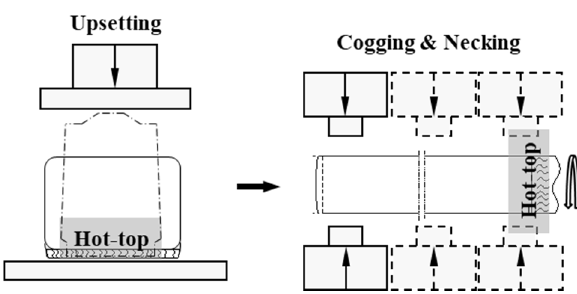
Figure 9. Schematic drawing of the round bar forging. Materials 2020 , 13 , x FOR PEER REVIEW